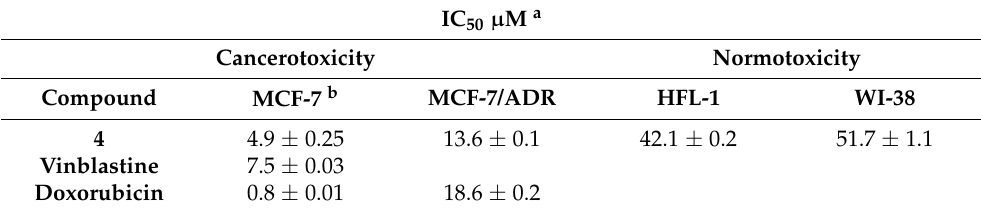
Table 4. Cytotoxic activity of the target compounds in the tested cell lines.